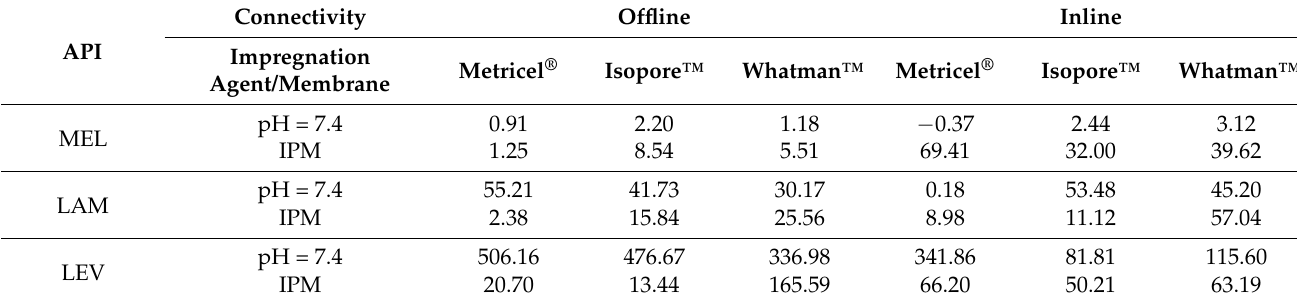
Table 6. Penetration extent (μg/cm 2 ) of MEL, LAM, and LEV at 15 min of measurements.